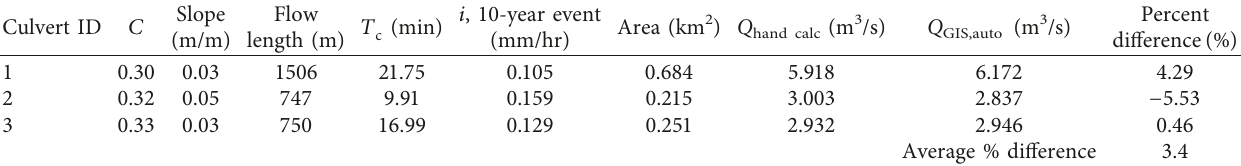
Table 3: Quality assurance and control results for three culvert drainage basins.